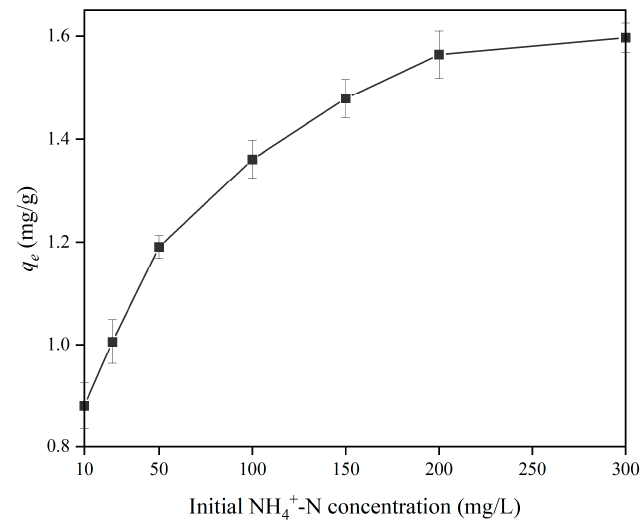
Figure 9. The effect of ammonium concentration on the adsorption capacity of